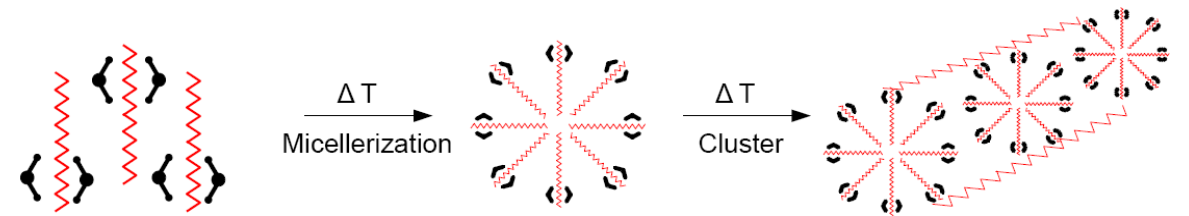
Figure 1. Cluster formation of EPE molecules dispersed in